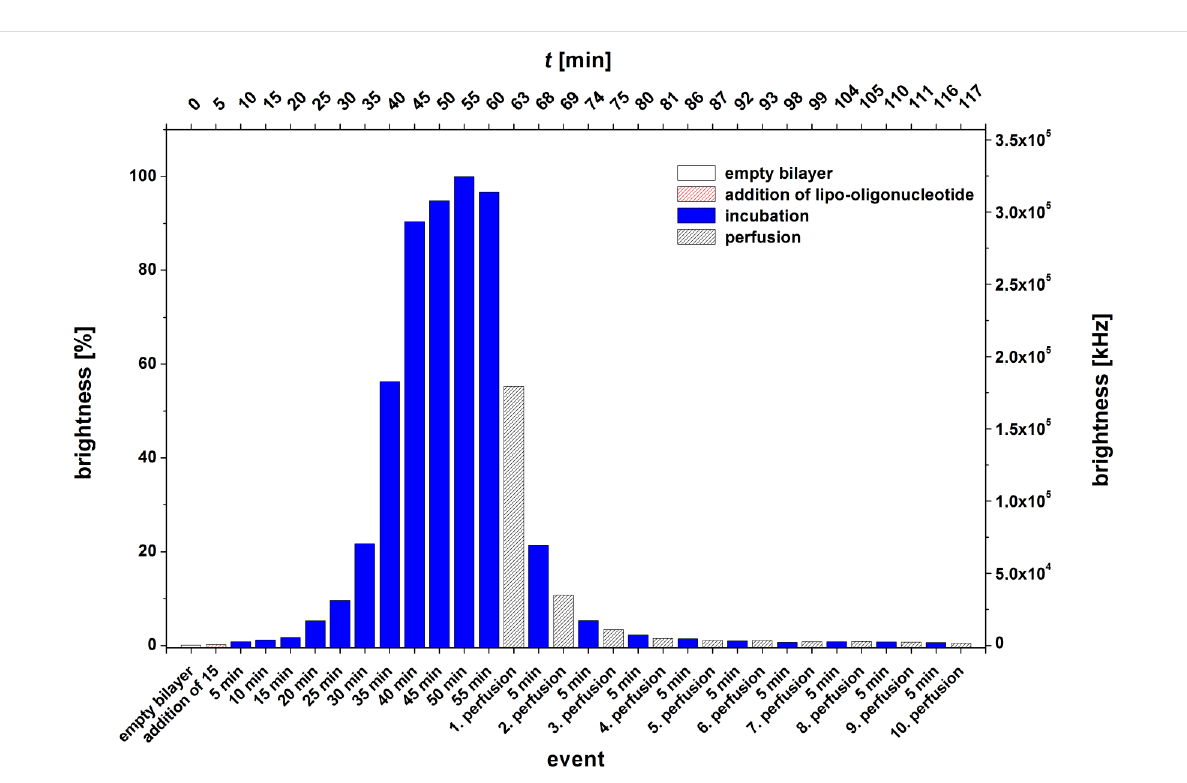
Figure 11: Bilayer brightness vs event graph of 5’-d( 9a -Cy5-TAG GTC AAT ACT) ( 15